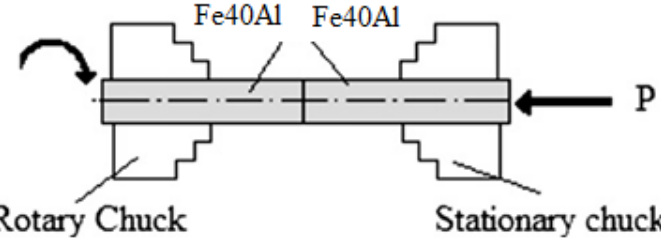
Figure 1. Schematic illustration of the friction welding process.